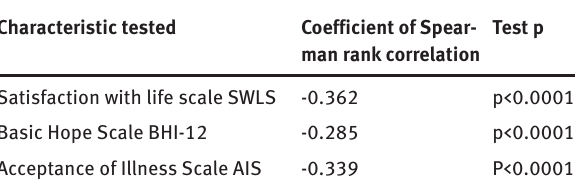
Table 9: Dependence between DJG scale of loneliness and selected psychometric scales